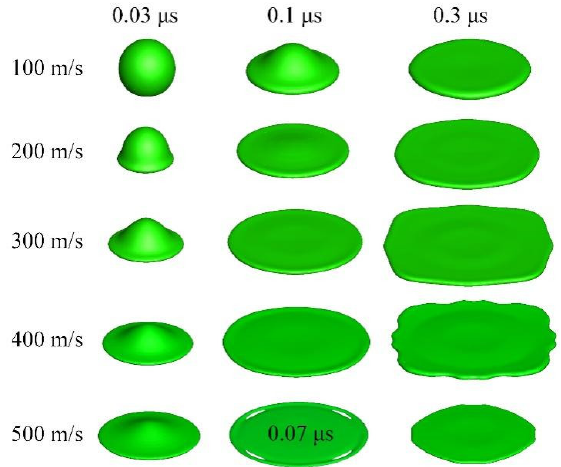
Figure 13. Effect of velocity on Ni drop